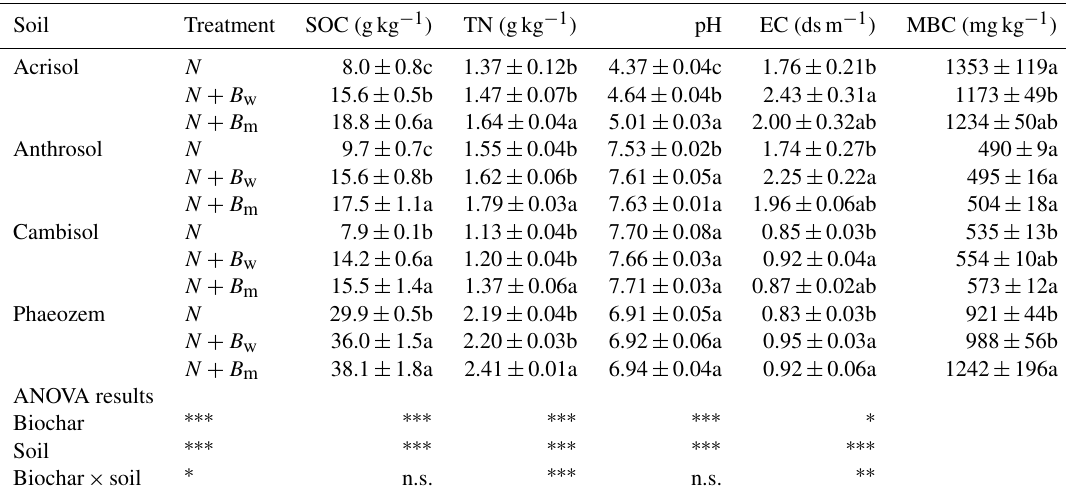
Table 1. Soil organic carbon (SOC), soil total nitrogen (TN), soil pH, electric conductivity (EC) and microbial biomass carbon (MBC) as affected by different treatments across the four vegetable soils. Soil